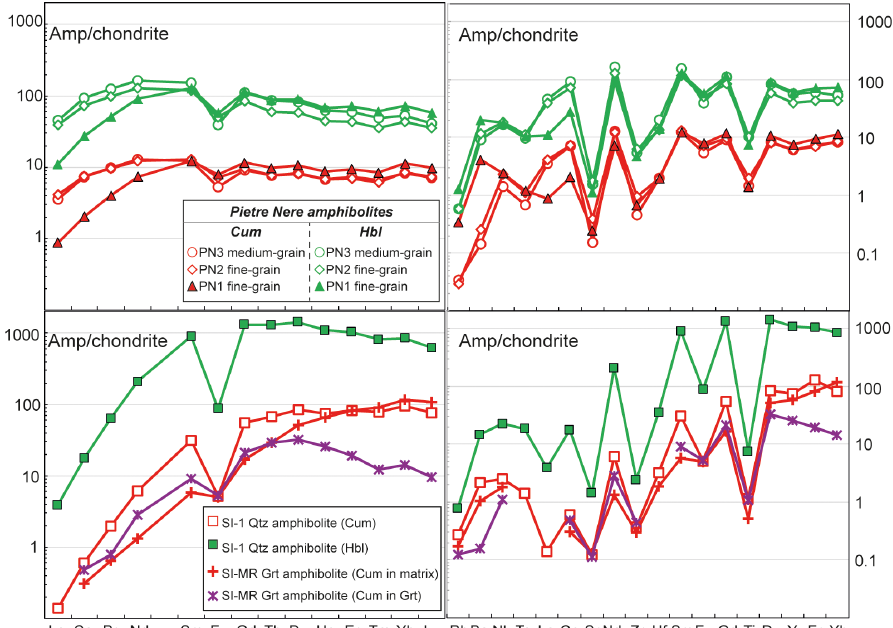
Figure 8. REE and incompatible-trace-element compositions normalized to chondrite (Anders and Ebihara, 1982) of cummingtonite and hornblende.